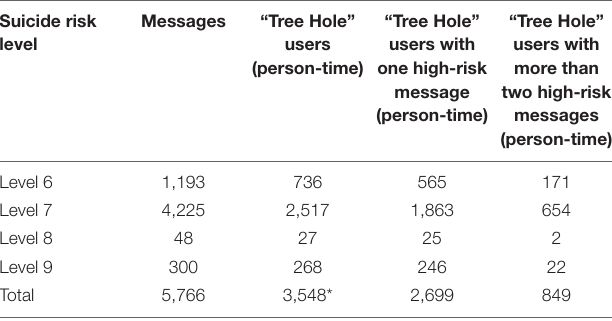
TABLE 3 | Users with high-risk messages identified by “Tree Hole Intelligent Agent” from November 2018 to May